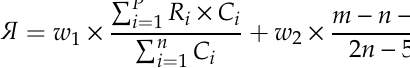
Figure 1. Resilience loss measurement